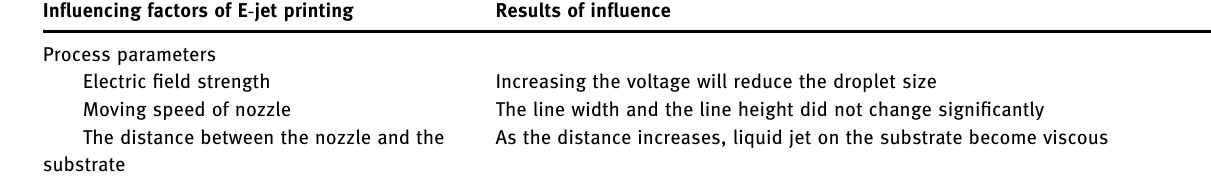
Table 1: In fl uencing factors of E - jet printing In fl uencing factors of E - jet